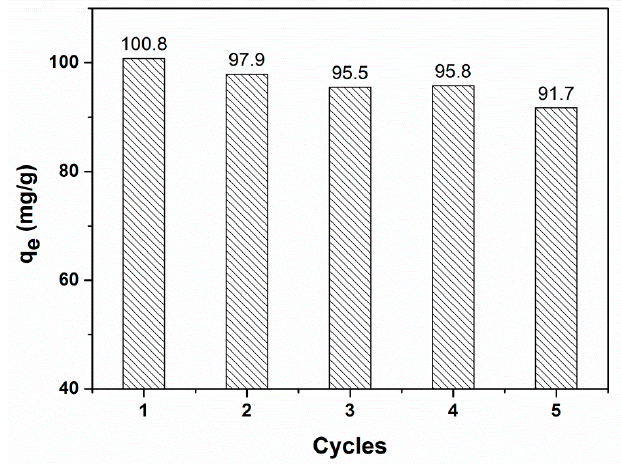
Figure 9. The adsorption capacity of CR on magnetic PGMA-g-PPy in five successive cycles of de- sorption–adsorption.